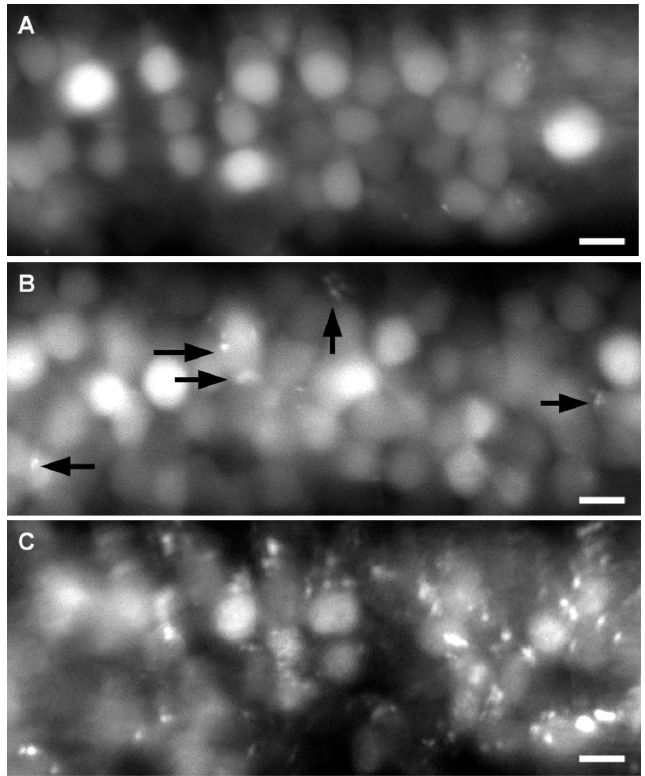
Figure 2. Effect of cyprodinyl and A6 on the central nervous system of nbt-dsred larvae. 1-dpf embryos were exposed to the solvent alone ( A ); to 20 μ M cyprodinyl ( B ); or to 20 μ M A6 ( C ), and their spinal cord neurons were visualized after two days of incubation. At least nine larvae were examined for each condition, with very similar results. Arrows indicate fluorescent inclusions. Scale bars: 10 μ m.